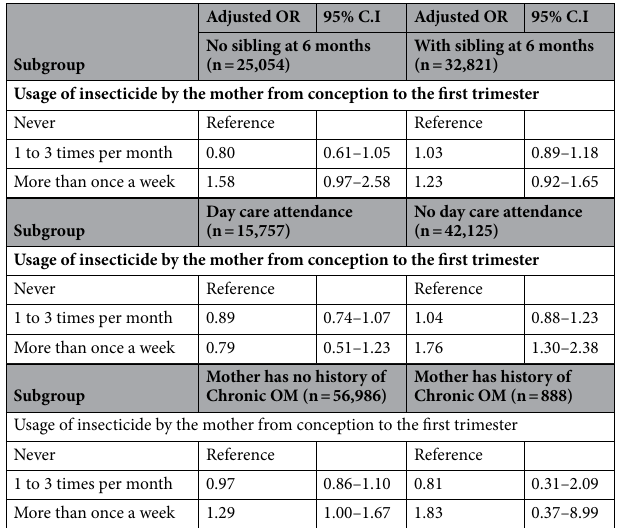
Table 4. Association between the history of otitis media in the first year in children and maternal insecticide use from conception to the first trimester in subgroup analysis. OR odds ratio, 95% C.I. 95% confidence interval, OM otitis media. There were three subgroups, including living with siblings at 6 months, daycare attendance, and maternal history of chronic otitis media. These analyses were adjusted for sex, exclusive breastfeeding for the first 6 months, maternal age, gestational age, birth weight, living with siblings at 6 months, daycare attendance, maternal history of chronic otitis media, Hib vaccination, pneumococcal vaccination, maternal and paternal smoking history, exposure to secondhand smoke, diagnosis of trisomy 21, fertility treatment, family member’s smoking, and maternal occupational category.